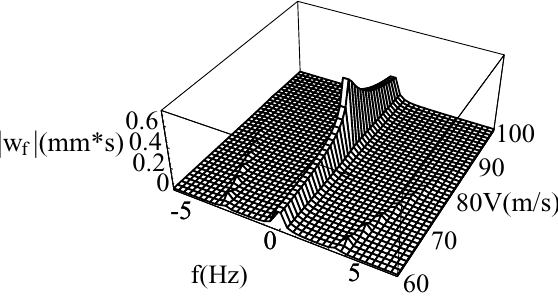
Fig. 6. The amplitude spectrum of the vertical displacements for a constant load and beam on a